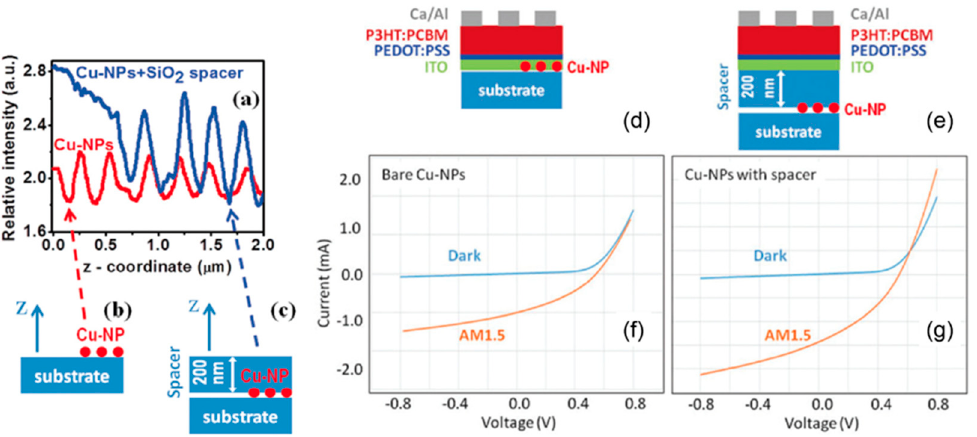
Figure 13. Intensity profiles of scattered light above the copper nanoparticles are shown in panel ( a ) for two cases of ( b ) bare nanoparticles and ( c ) nanoparticles modified with an SiO 2 spacer. Intensity enhancement of scattered light is observed when the spacer is in place. These films are subsequently incorporated into solar cell architectures of ( d ) the reference solar cell containing bare copper nanoparticles without a spacer and ( e ) the enhanced cell including a 200 nm SiO 2 spacer. I–V characteristics of the solar cells with a Cu-nanoparticle plasmonic layer ( f ) without and ( g ) with the SiO 2 spacer between copper nanoparticles and the ITO-P3HT/PCBM solar cell active layer. Reproduced with permission from [48], Copyright Nanoscale, 2015.